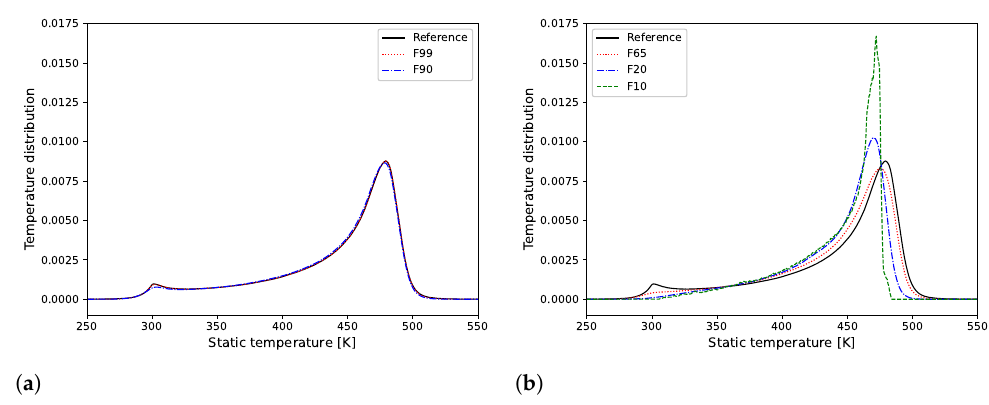
Figure 17. Distribution of static temperature at plane 40. ( a ) F99, F90. ( b ) F65, F20, F10.